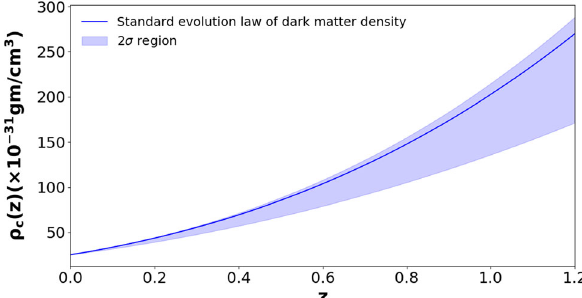
Fig. 3 The evolution law for the dark matter density as a function of redshift. The light blue shaded area shows the 2 σ allowed region for the evolution law as found in this work. The standard evolution law for the dark matter density is indicated by the solid blue line